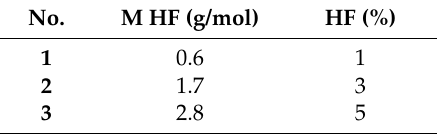
Table 2. Concentration of the hydrofluoric acid in baths used for scaffolds polishing. No. M HF (g/mol) HF (%) 1 0.6